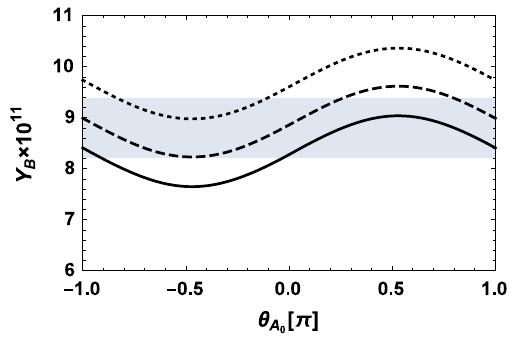
= − 0 . 3 (solid line), − 0 . 4 (dashed line), Fig. 4 Y B versus θ A for g YB 0 − 0 . 5 (dotted line), and the gray area denotes the experimental interval ( 8 . 2 − 9 . 4 ) × 10 −